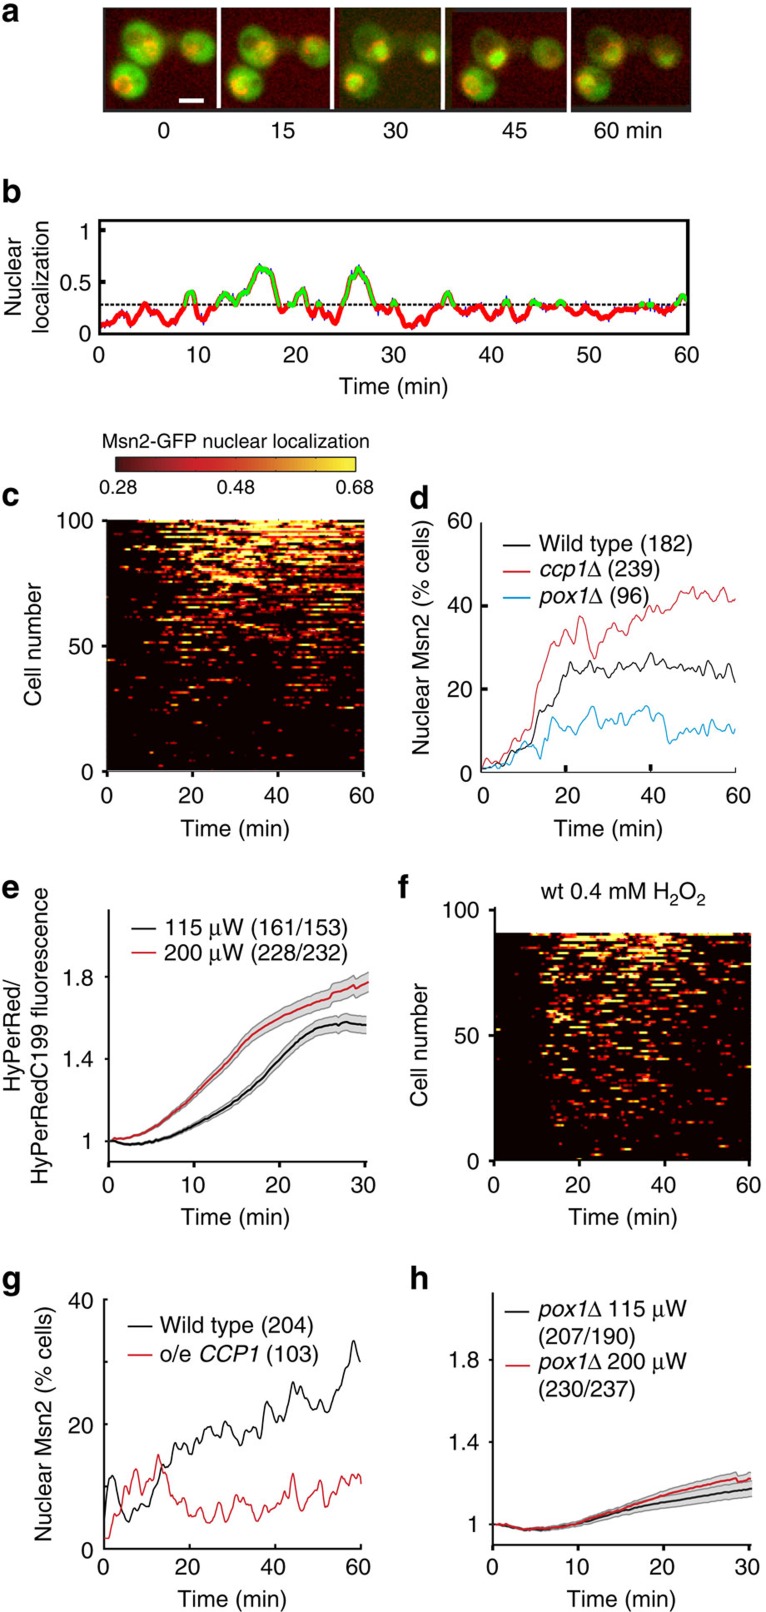
H2O2 is necessary and sufficient for light-induced nuclear translocation of Msn2.(a) Frames from Supplementary Movie 1 showing that Msn2-GFP (green) rhythmically shuttles into and out of the nucleus upon illumination of cells with blue light (intensity 115 μW). Nup49-mCherry (red) was used to visualize the nucleus. Scale bar, 5 μm. (b) Single-cell trace representing nuclear localization upon illumination of a wild-type (wt) cell, quantified by comparing the signal intensity in the nucleus with the signal intensity in the cytosol (see Methods). The dashed line indicates the threshold ratio of nuclear/cytosolic Msn2 signal for nuclear localization in population analyses14. (c,f) Msn2 nucleocytoplasmic localization trajectories in individual wt cells upon illumination (115 μW, c) or upon the addition of 0.4 mM H2O2 (f). The colour scale indicates the degree of nuclear localization. (d,g) Fraction of wild-type, ccp1Δ and pox1Δ cells (d) or cells overexpressing (o/e) CCP1 or not (g) displaying nuclear localization of Msn2 following illumination at 115 μW. The number of cells assayed in each analysis are indicated in brackets. (e,h) Cytosolic H2O2, measured as average Cys199-dependent HyPerRed fluorescence, upon illumination of wt (e) and pox1Δ cells (h) at the indicated light intensities. Error bars indicate s.e.m. The number of HyPerRed/ HyPerRedC199S cells assayed in each analysis are indicated in brackets.